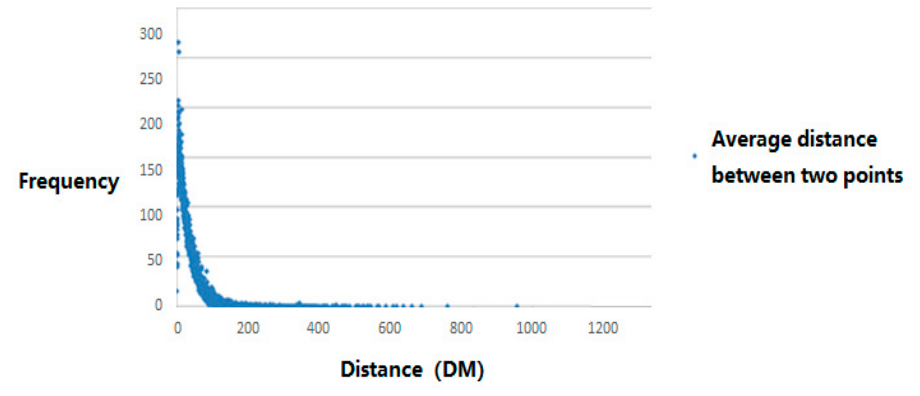
Figure 6. Distance threshold determination.